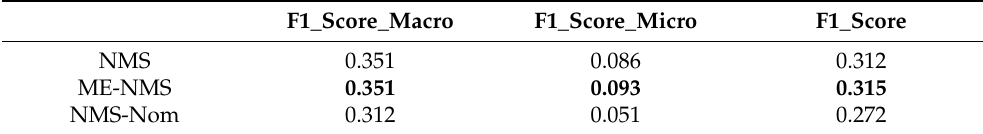
Table 4. Performance of ME-NMS.